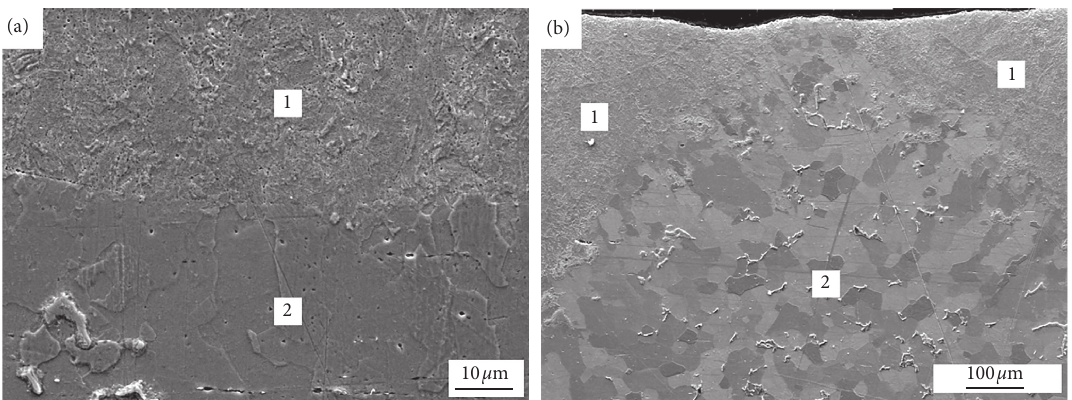
Figure 9: Microstructure of the transition zone: (a) magnification × 1000; (b) magnification × 250; (1) surface layer after laser processing; (2) untreated zone.